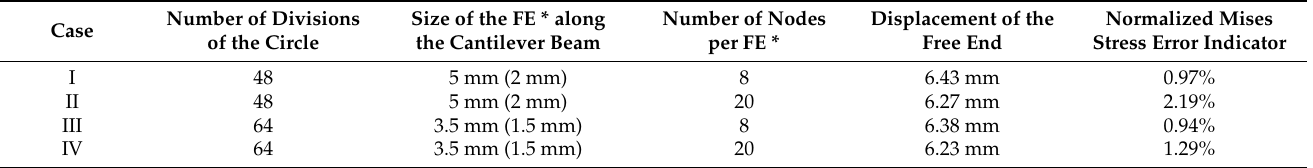
Table 4. A mesh sensitivity analysis.